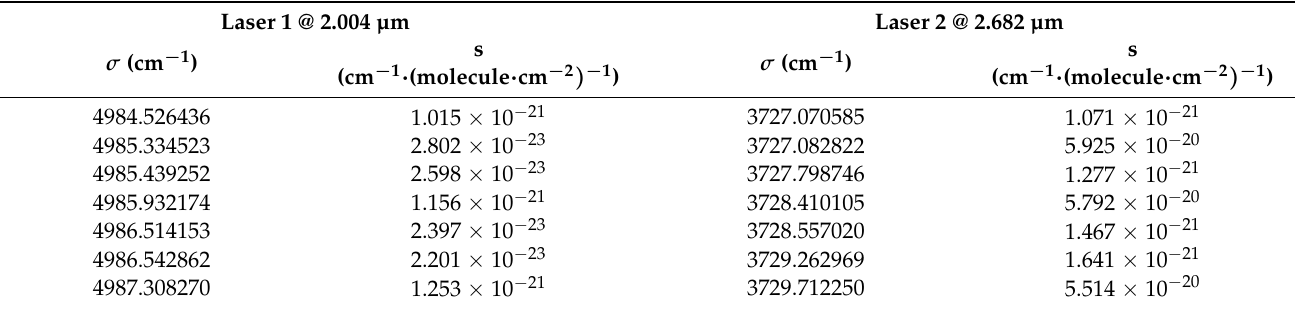
Table 2. List of the positions in wavenumber ( σ ) and absorption strength (s) of the lines contributing to the Beer–Lambert fit of the recorded transmissions for both lasers. These data are taken from the Hitran database for a temperature of 296